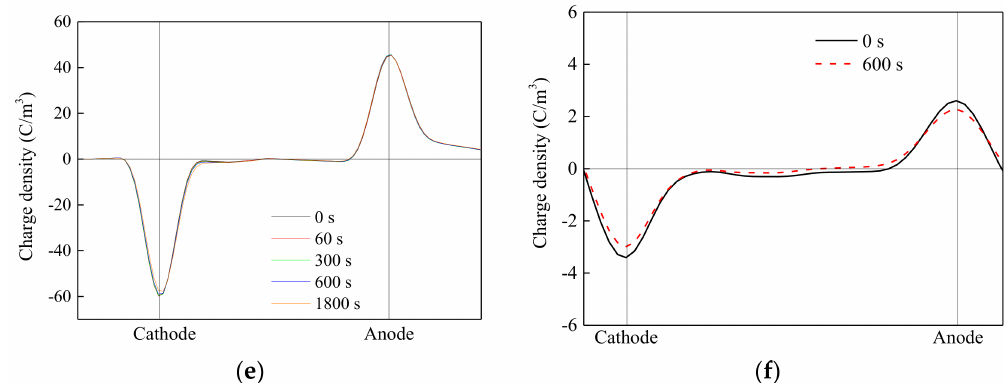
Figure 4. Space charge distribution at a strength of 60 kV/mm and short circuit. ( a , b ) was the space charge distribution of PP with voltage applied and in a short circuit, respectively. ( c , d ) was the space charge distribution of PP with a 10 phr POE content, with voltage applied and in a short circuit, respectively. ( e , f ) was the space charge distribution of PP with 10 phr POE and 1 phr nano-SiO 2 content with voltage applied and in a short circuit,